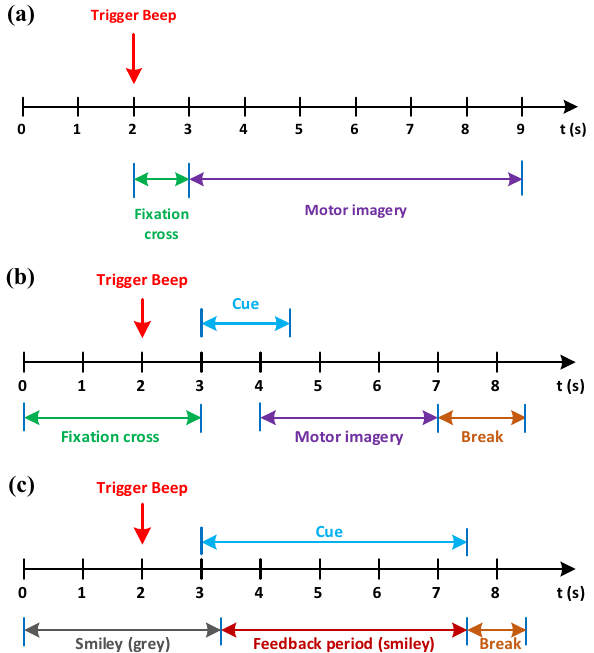
Figure 2. Timing scheme for recording EEG signals in each trial. ( a ) dataset II–III, ( b ) first two sessions of dataset IV-2b, ( c ) last three sessions of dataset